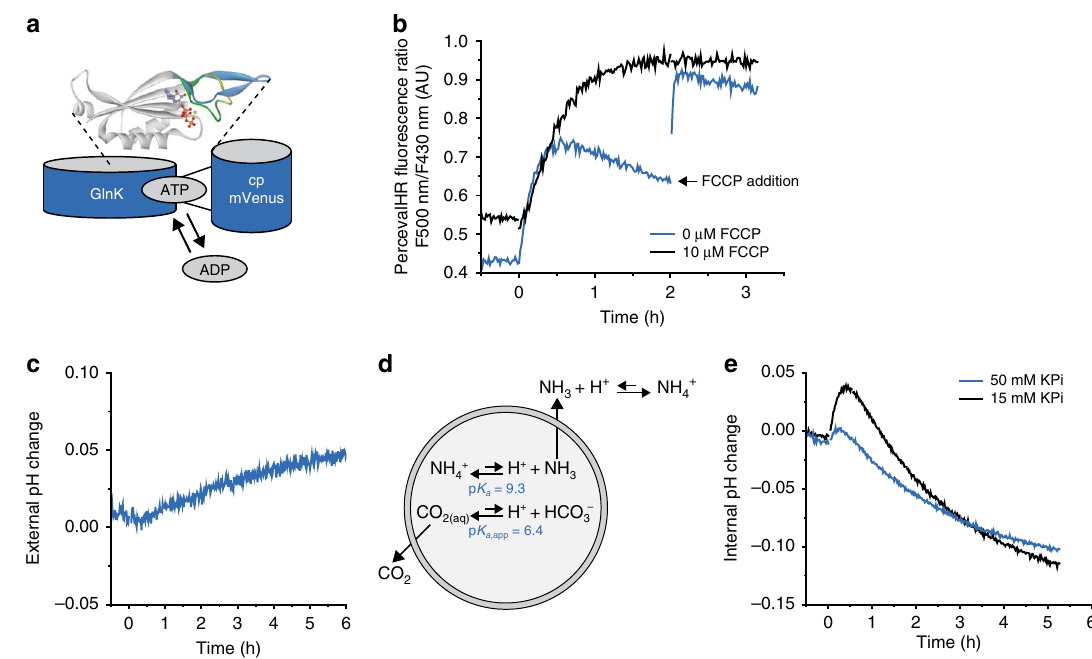
Fig. 3 Generation of ATP and pH changes. The internal composition of the vesicles at the start of the experiment is given in Fig. 2a (enzymes) and Table 2 (ions, metabolites) and the preparation of vesicles is given in protocol A1, unless speci fi ed otherwise. a Schematic representation of PercevalHR; modi fi cation of cartoon in ref. 32 . b Effect of FCCP on the fl uorescence readout of PercevalHR (protocol A1); the ratio of the fl uorescence peaks at 500 nm and 430 nm is shown. In the absence of FCCP, the fl uorescence readout declines 30 min after addition of 10 mM arginine (at t = 0) due to changes in the internal pH (addition of FCCP after 2 h increases the signal, indicated by the black arrow). The fl uorescence signal is constant for several hours in the presence of 10 µ M FCCP ( n = 2). c External pH change (protocol B5 ) of arginine-metabolizing vesicles in outside medium with 10 mM KPi pH 7.0 plus 355 mM KCl. The ATP production was started by adding 5 mM arginine at t = 0. d Schematic representation of the pH effects caused by ammonia and carbon dioxide diffusion. e Internal pH change (protocol B4) of arginine-metabolizing vesicles with either 50 mM (blue trace) or 15 mM KPi plus 40 mM KCl, pH 7.0 on the inside (protocol A2; black trace). Five millimolar arginine was added at t = 0 ( n =